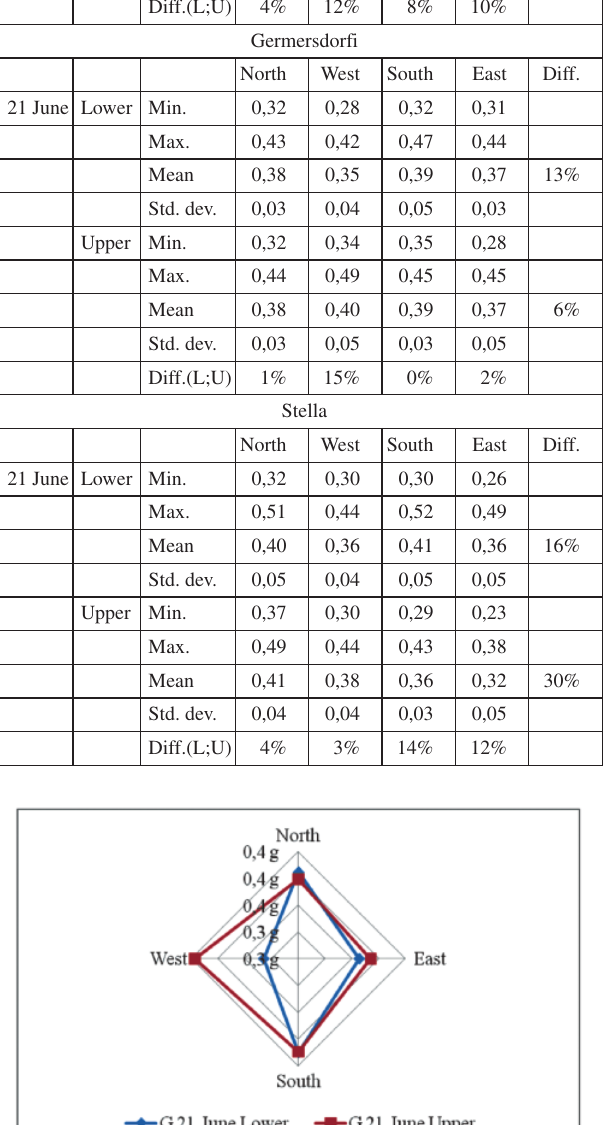
Fig. 11: Stone mass in the function of orientation and height in the case of Stella [g]